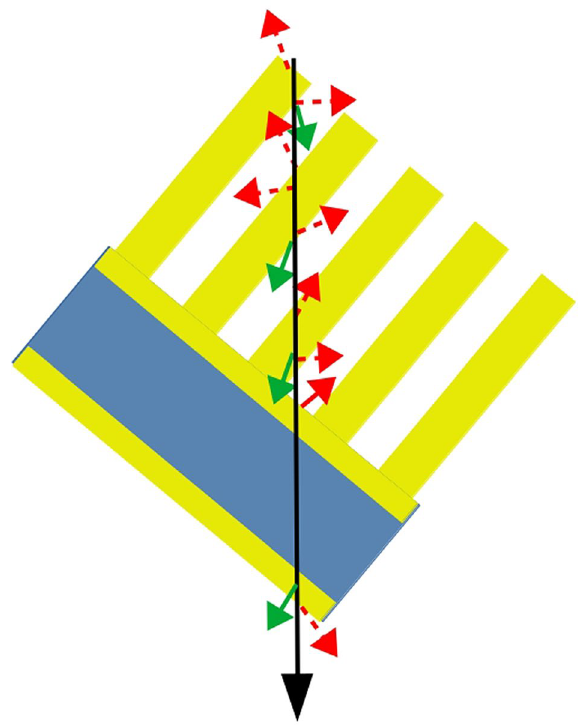
Figure 6. A concept of using a nanostructure to increase the SEY per ion. a) a side view of a regular nanostructure. The heavy ions depicted by the black arrow/line interact with the sample knocking slow electrons depicted in red, and δ-electrons depicted in green. A significant gain in the SEY is obtained due to passing through multiple entrance and exit